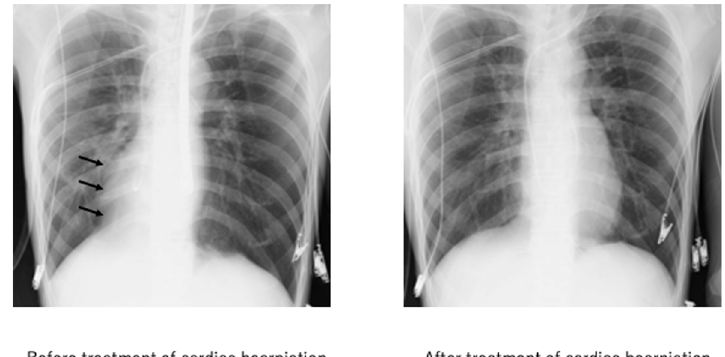
Fig. 2 Chest XP before (left) and after (right) treatment of cardiac hernia. The heart in the right hemithorax was repositioned to the normal position after right one-lung ventilation. Black arrow: protrusion of the right cardiac